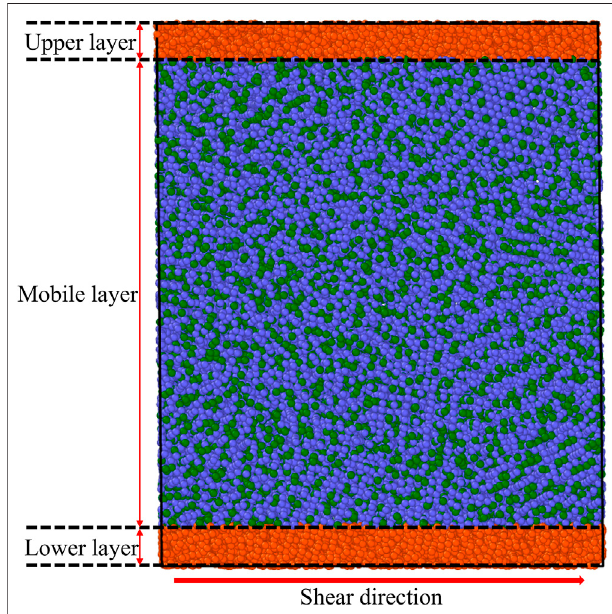
FIGURE 1 | An example illustrating the model for the shear deformation. Duringsheardeformation,theatomsinthelowerlayerare fi xedandtheatoms in upper layer have the maximum velocity of 20 m/s along the shear direction. The velocity of atoms in the mobile layer increases linearly from the bottom boundary to the upper boundary. In the mobile layer, the Cu and Zr atoms are represented by blue and green balls.